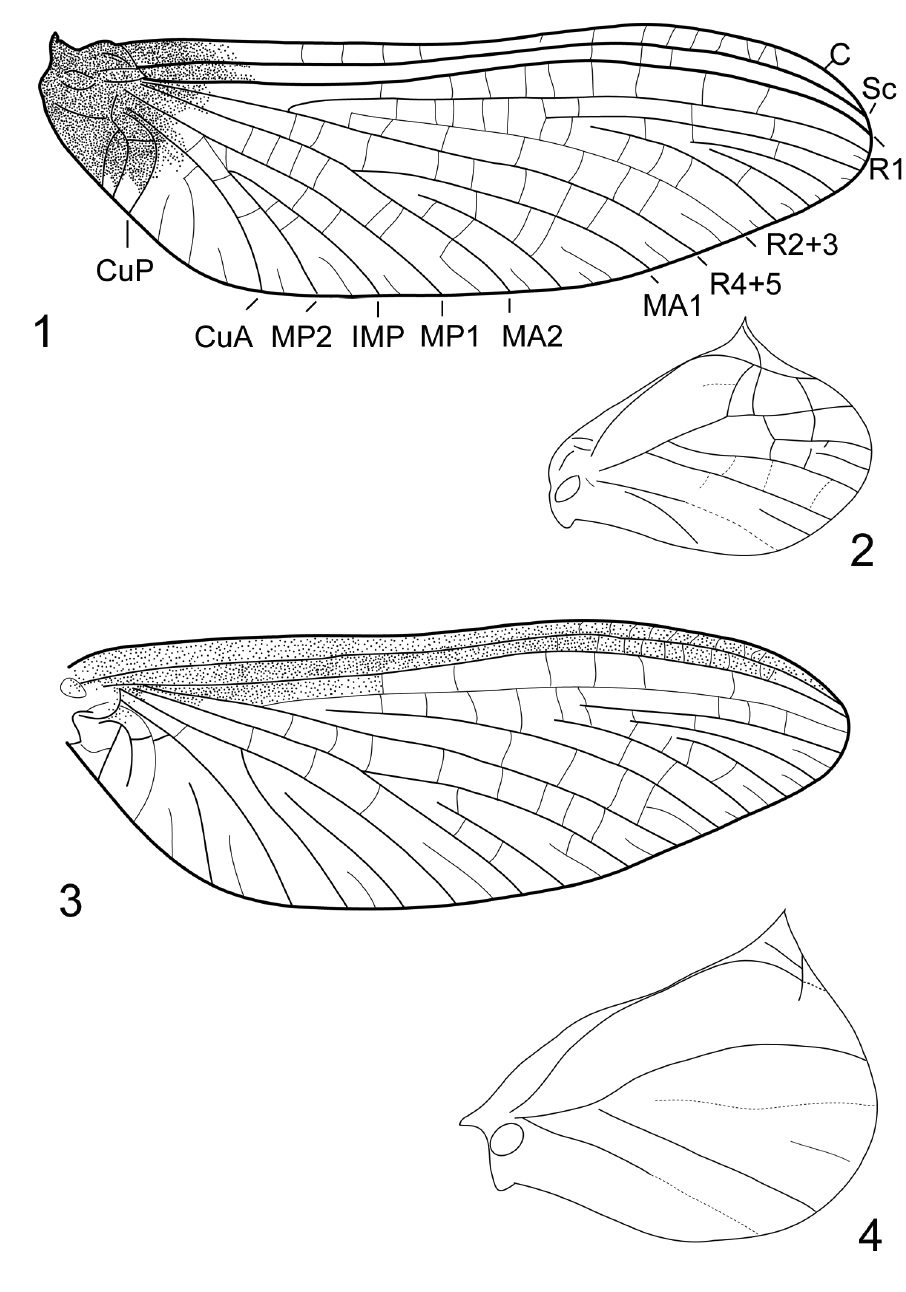
Figures 1–4. Manohyphella keiseri Allen, 1973 adults. 1 male forewing 2 male hindwing 3 female fore- wing 4 female hindwing. Abbreviations: C Costa Sc Subcosta R Radius MA Media anterior MP Media posterior IMP Main intercalary vein in media posterior CuA Cubitus anterior CuP Cubitus